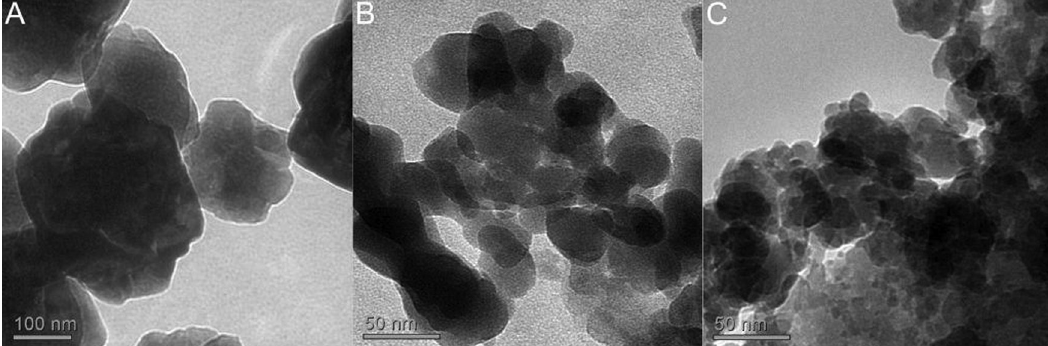
Figure 2 TEM images for samples A – C .